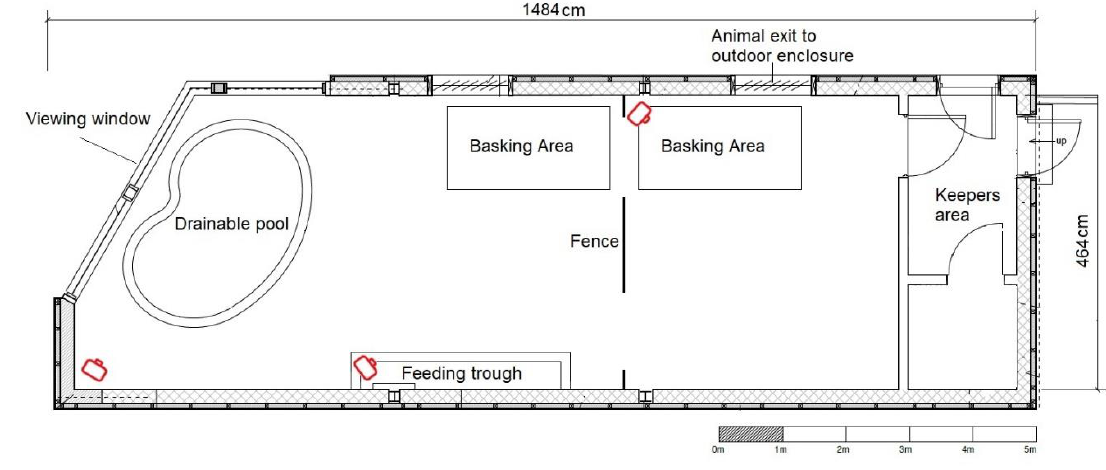
Figure 1. A map of the indoor Galápagos tortoise enclosure at ZSL London Zoo. The red symbols indicate the location of the cameras.